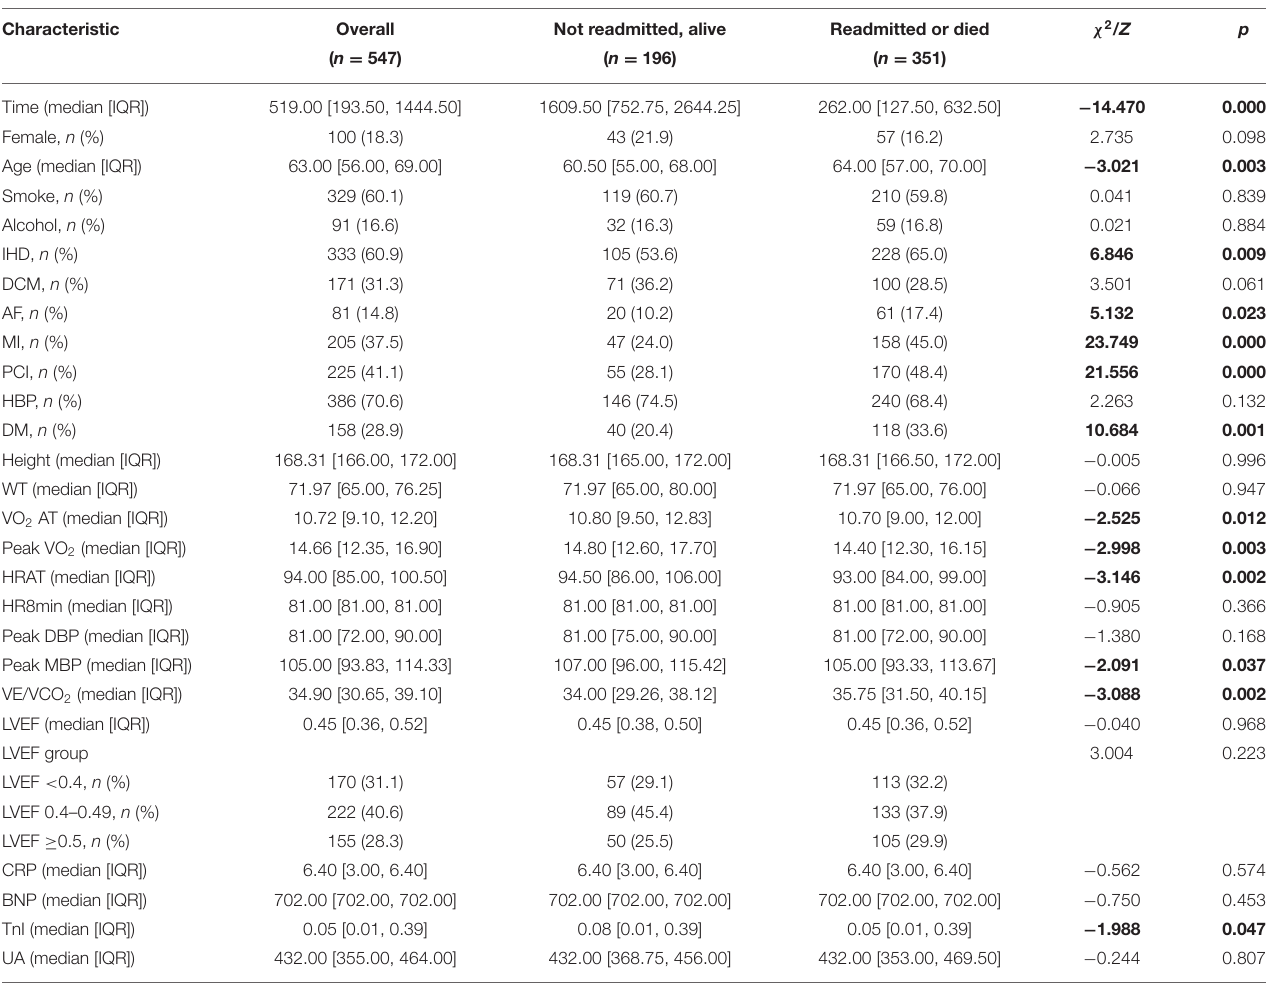
TABLE 1 | The characteristics of death or readmission stratification in patients with CHF. Characteristic Overall Not readmitted, alive Readmitted or